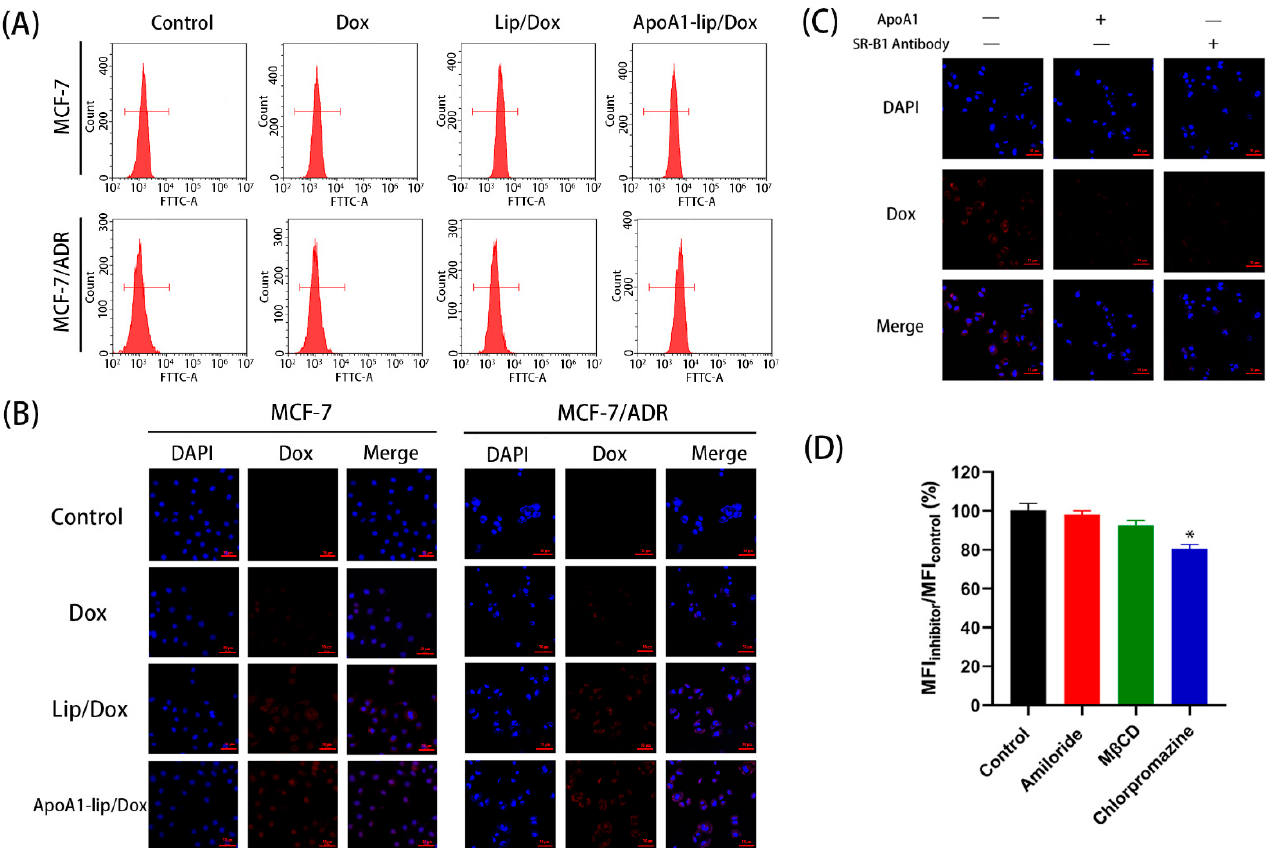
Figure 3. Cellular uptake profile of Dox-loaded liposomes. ( A , B ): Intracellular fluorescence of Dox measured by flow cytometry and a confocal laser scanning microscope (CLSM). The cells were co-incubated with different Dox liposomal formulations for 2 h. ( C ) Confocal observation after treating cells with free Dox, Lip/Dox, ApoA1-lip/Dox after pretreatment of 0.5 mg/mL anti-SR-B1 (scavenger receptor, class B type 1) antibody and ApoA1 for 2 h. ( D ) Effect of endocytosis inhibitors on cellular uptake. The percentage of cellular uptake was calculated by the Median Fluorescence Intensity (MFI) value of the inhibitor group normalized with that of the control group (100%). Cells without inhibitors were regarded as a control ( n = 3; * p < 0.05, compared with control).